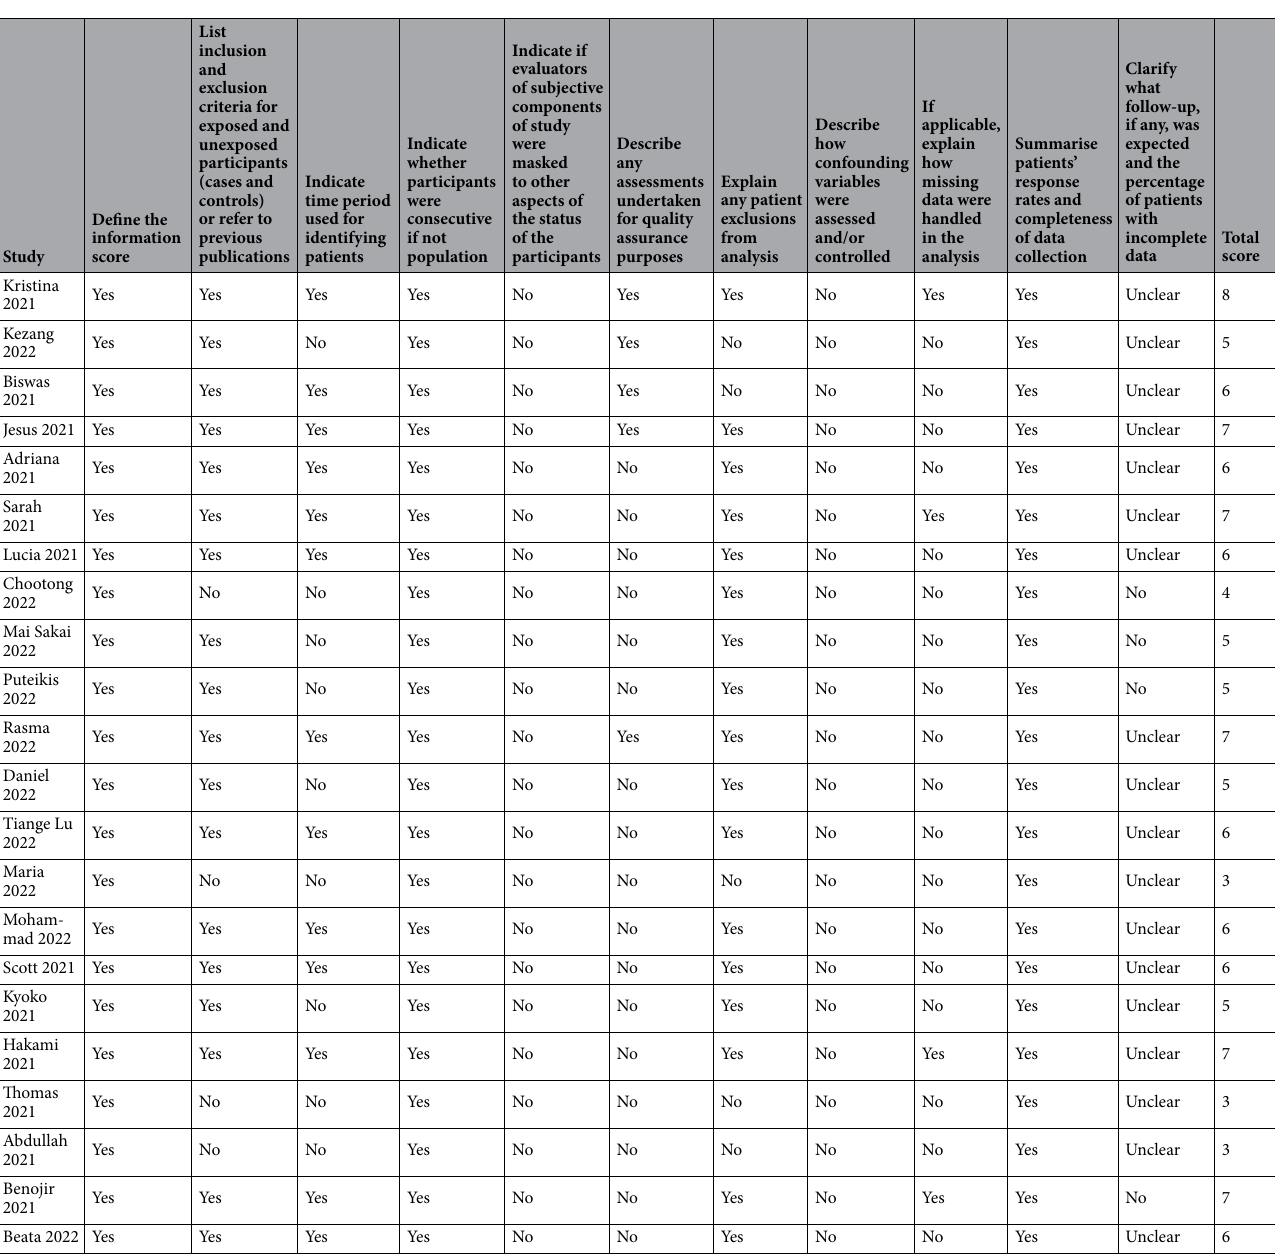
Table 2. Quality rating of included studies using the criteria of the American Agency for Health Care Quality and Research Cross-Sectional Research Literature Quality Assessment Checklist (AHRQ